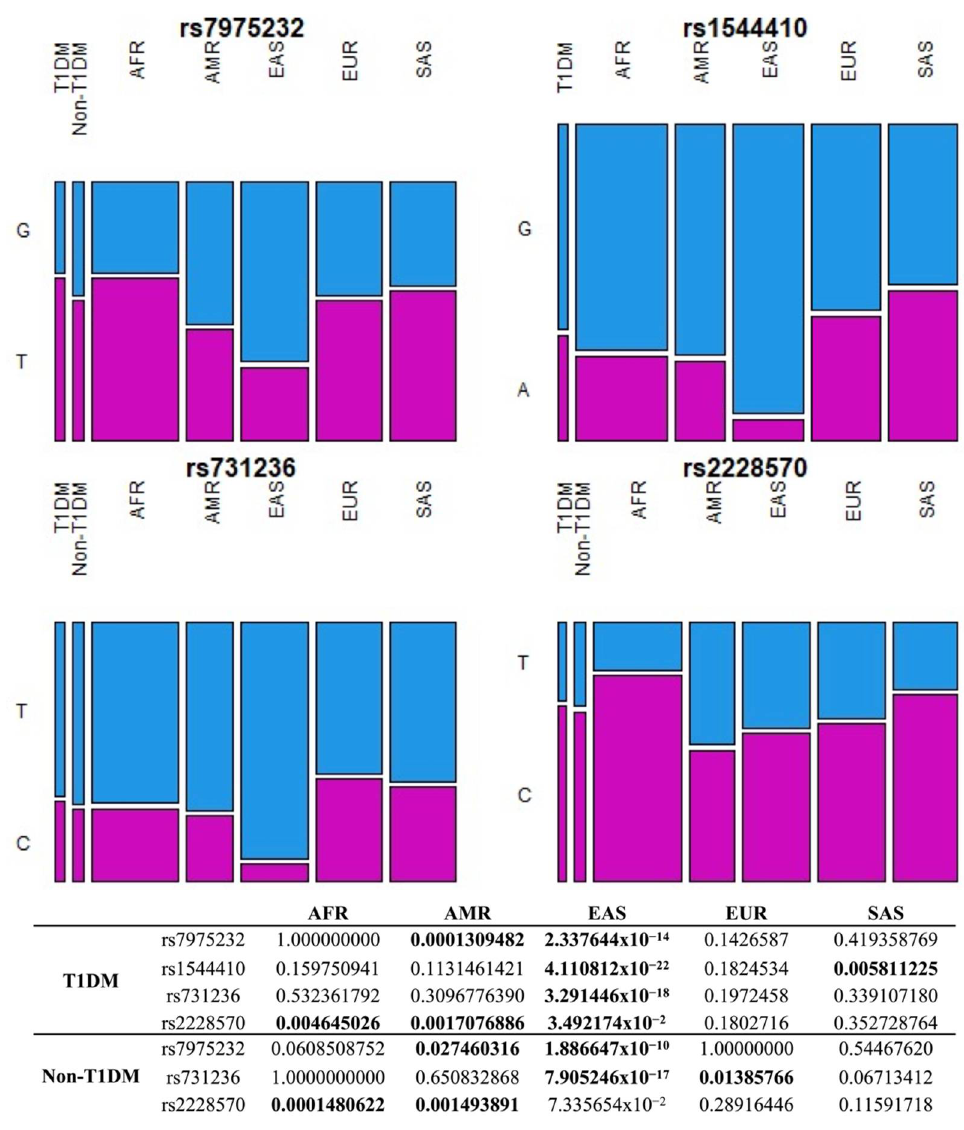
Figure 3. Pairwise comparison of allele frequencies of VDR polymorphism in T1DM and non-T1DM with each of the five continental populations from the 1000 Genomes database. Values in bold indicate a statistically significant difference ( p -value < 0.05). AFR: African, AMR: American, EAS: East Asian, EUR: European, SAS: South Asian, T1DM: Type 1 diabetes mellitus.